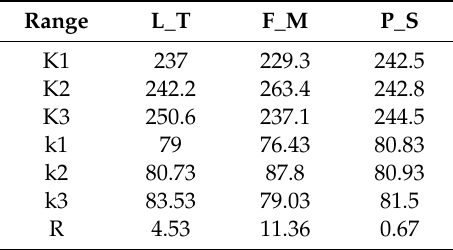
Table 6. Range analysis of surface roughness.